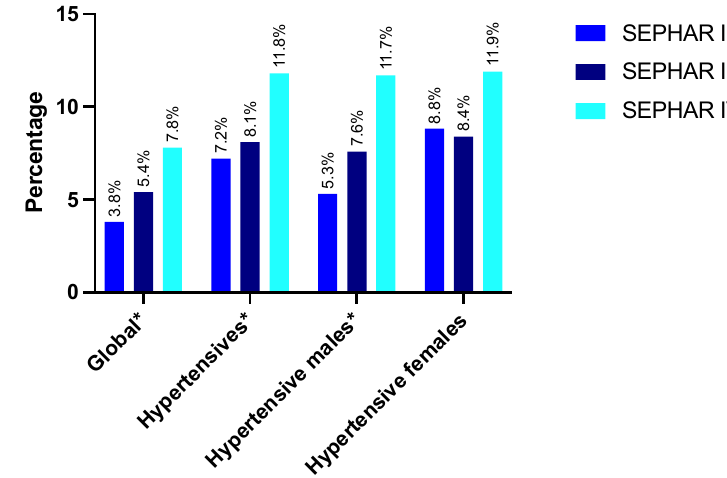
Figure 2. Atrial fibrillation prevalence trends in hypertensive subjects enrolled in SEPHAR II, III and IV surveys in Romania, * p < 0.05 for inter ‐ group comparison.